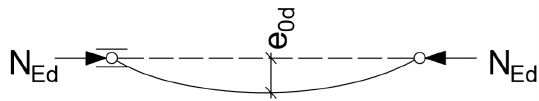
Figure 4. Initial geometrical imperfection.